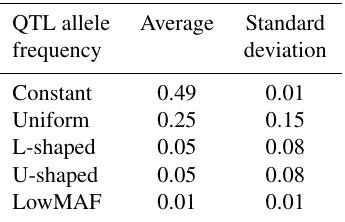
scription of the first four QTL allele frequency distributions Table 2. Average of the MAF in different distributions of the QTL allele